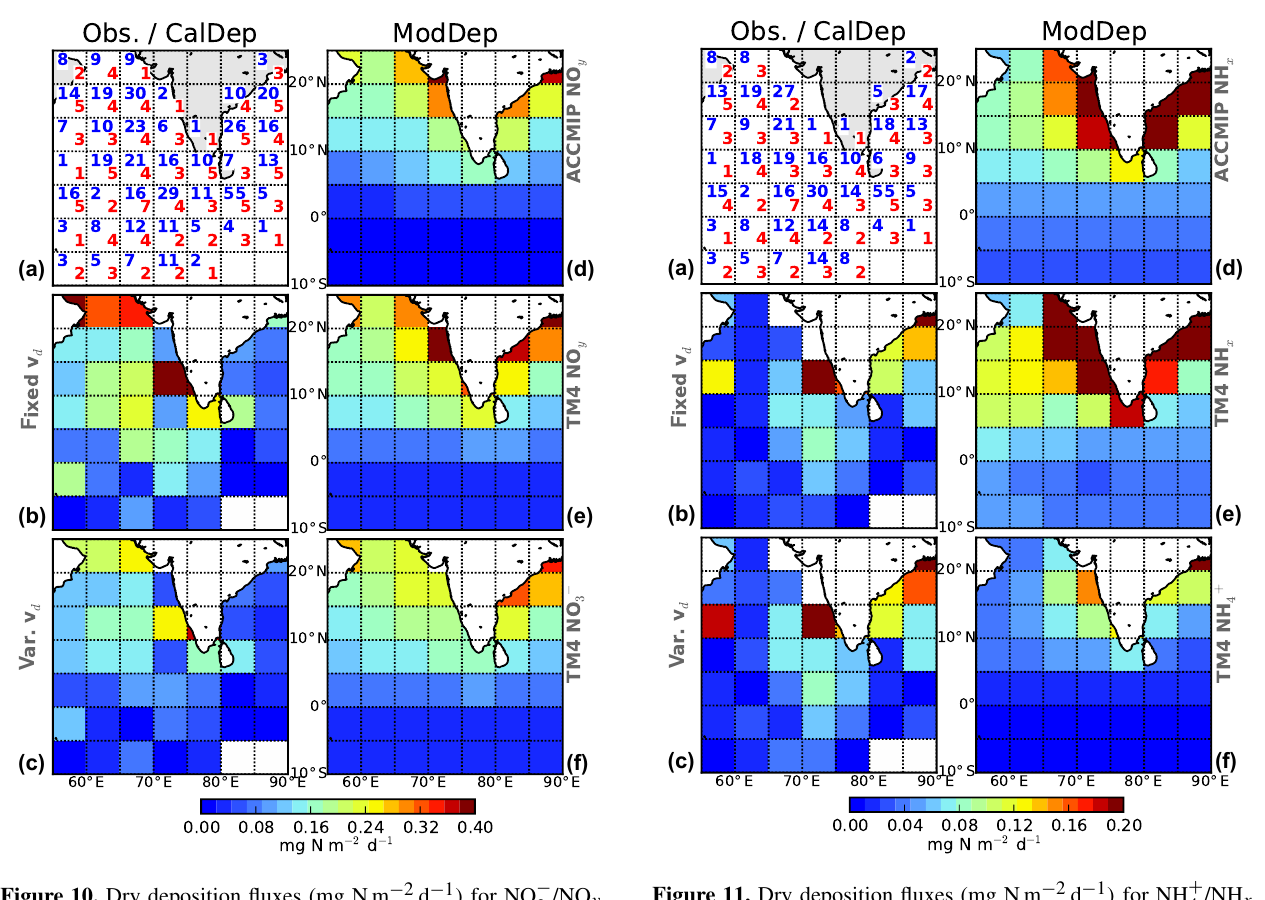
Figure 10. Dry deposition fluxes (mg Nm − 2 d − 1 ) for NO − for the NInd region. Panels are as described in Fig. 8.